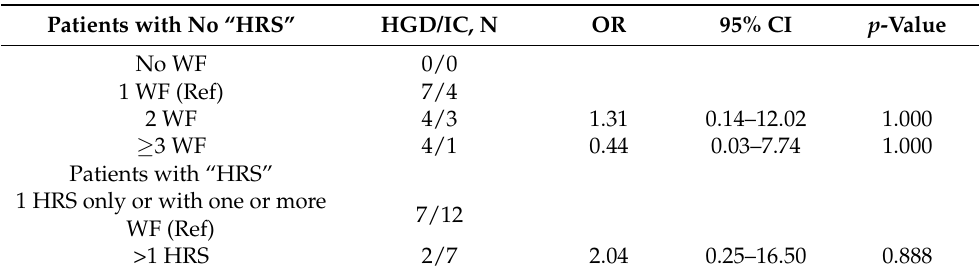
Table 5. Prediction of IC based on number of presence of “WF” and/or instances of “HRS” in patients with high-risk